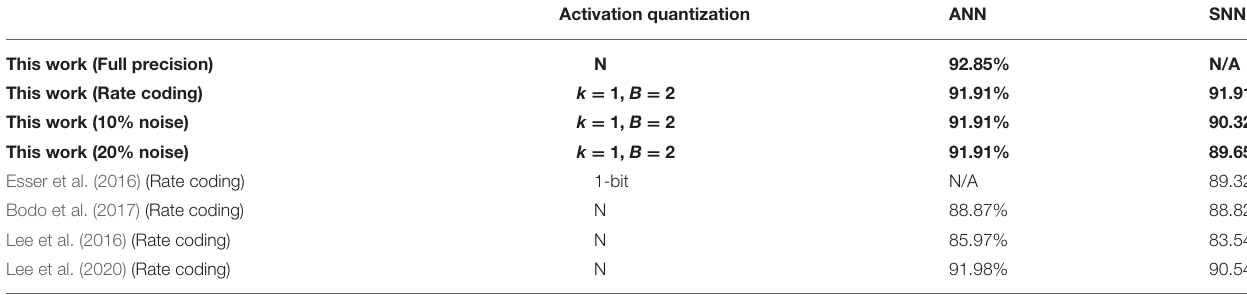
TABLE 5 | Classification accuracy on CIFAR-10.